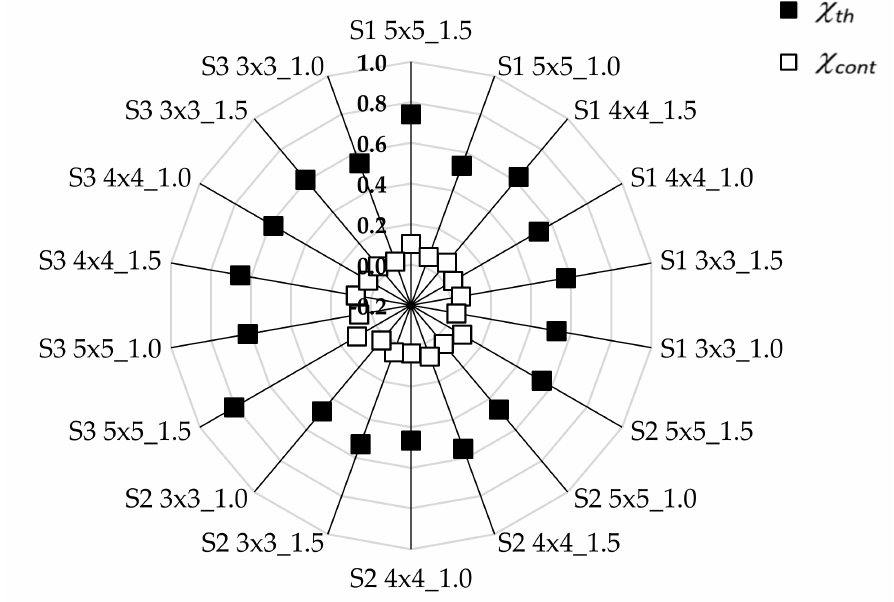
Figure 7. Connectivities of strips’ and strip contacts’ phases. Parameters m th , m cont , χ th , and χ cont were connected with the woven structure and especially with percentage surface cover C str , as shown in Table 7. Some dependences were observed and are presented in Figure 8.